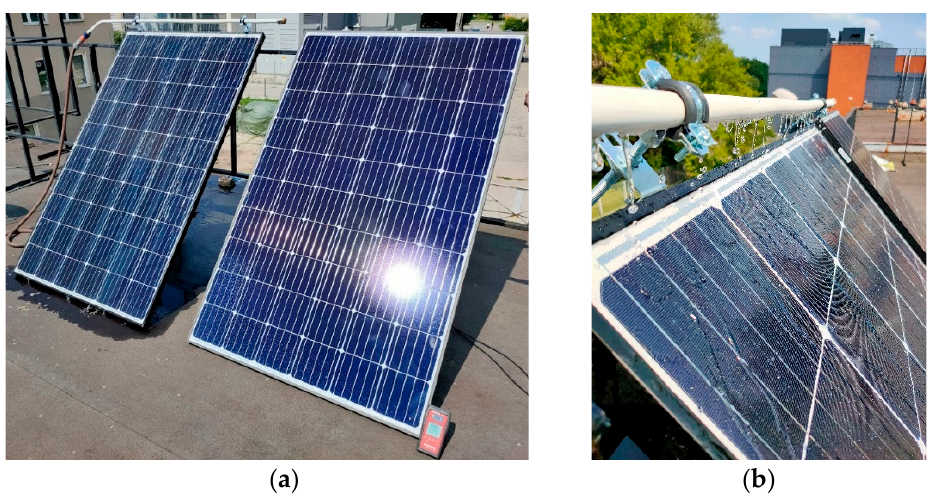
Figure 5. Experimental rig no. 2: ( a ) the general view of the experimental rig no. 2 with shown elements located on the roof, ( b ) a part of the water cooling system (header) installed on the tested 310 Wp PV panel.